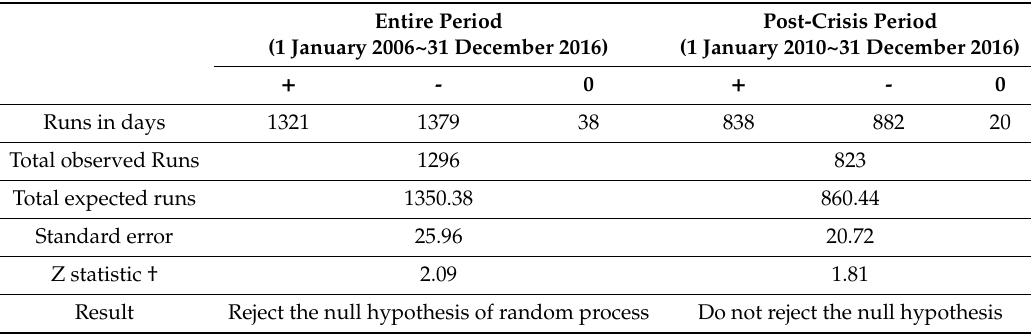
Table 3. Currency price change runs: Signs and test result.